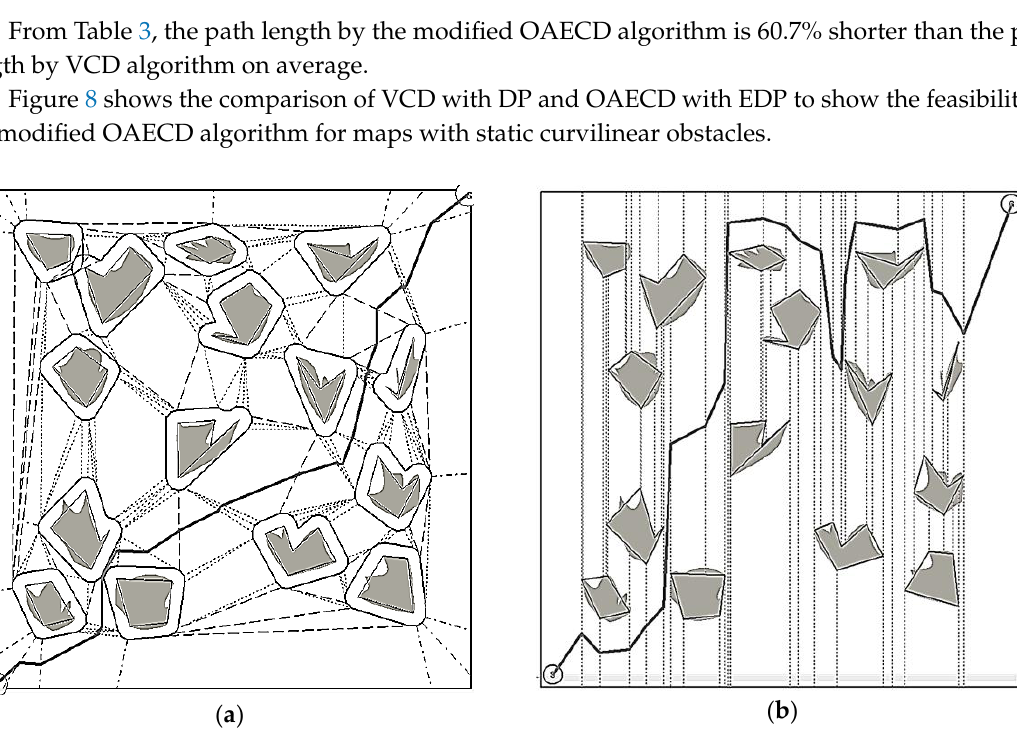
Figure 8. Comparison between OAECD with EDP and VCD with DP (ε = 0.05 m): ( a ) Path planning using EDP and OAECD; ( b ) Path planning using DP and VCD (The numbers of obstacles and vertices of each obstacle were fixed as 15, and θ rot for EDP was fixed as 30°).